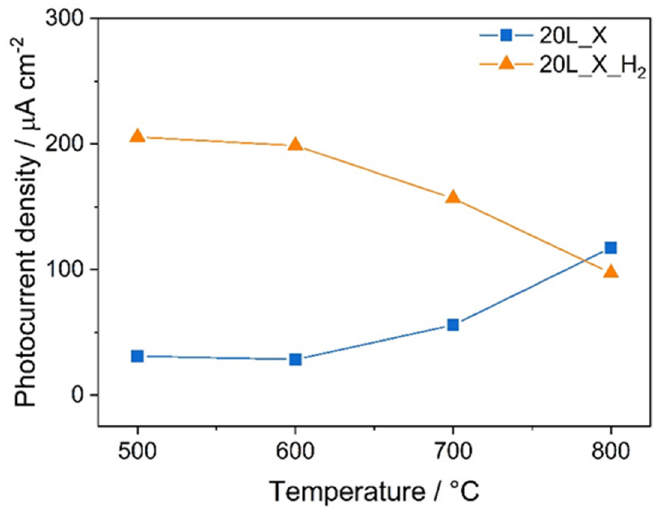
Figure 7. Photocurrent density measured with the 20L films at 1.5 V vs. RHE as a function of the annealing temperature.